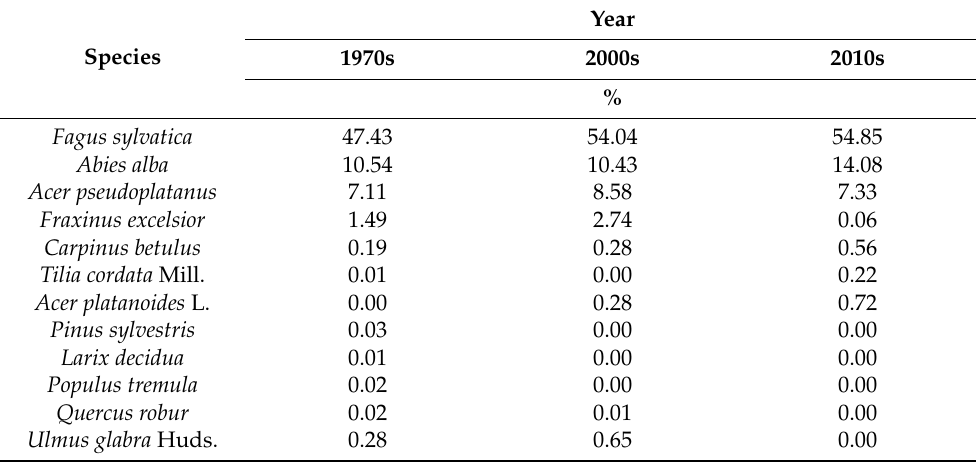
Table 2. Mean percentage of canopy tree species in semi-permanent sampling plots.